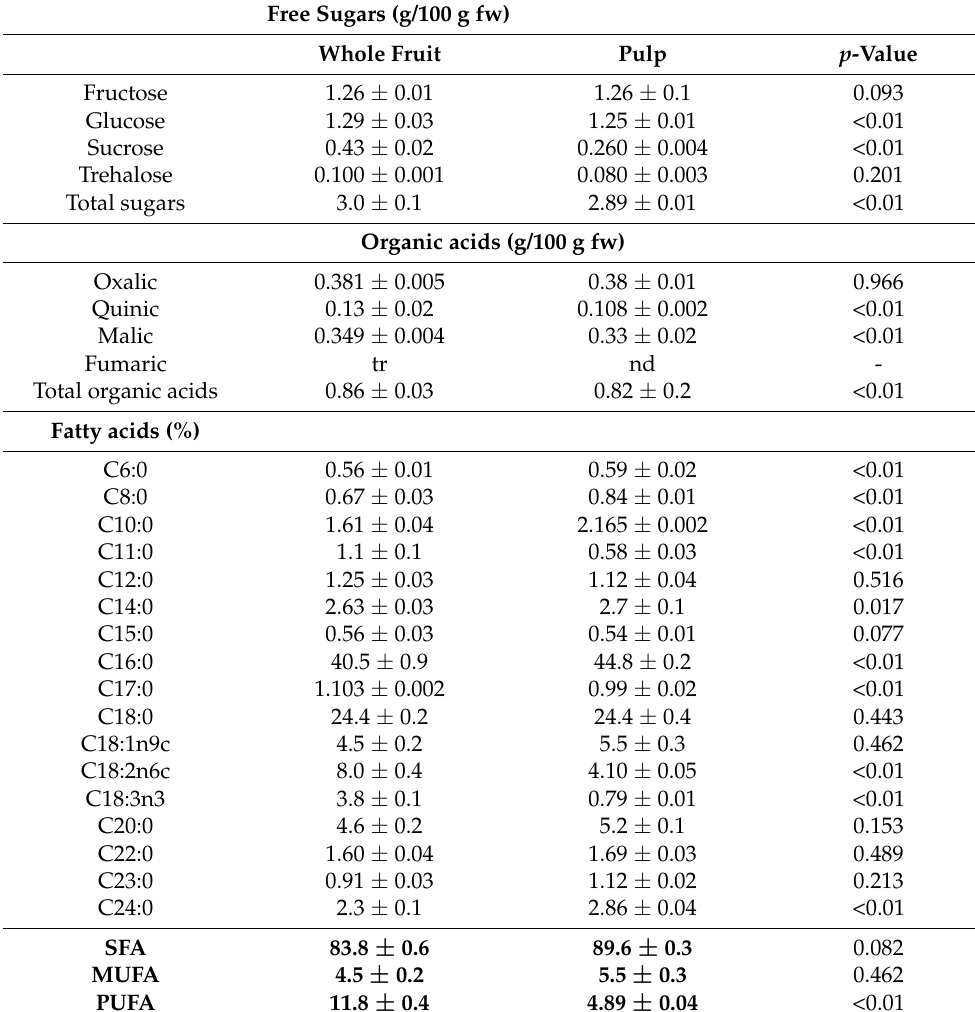
Table 4. Free sugars, organic acids, and fatty acids profile of in Solanum melongena L. whole fruit and pulp (mean ±